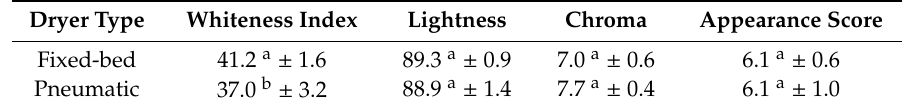
Table 4. Whiteness Index, lightness, chroma and appearance score of cassava flour produced using a fixed-bed dryer and a pneumatic dryer in Ghana.